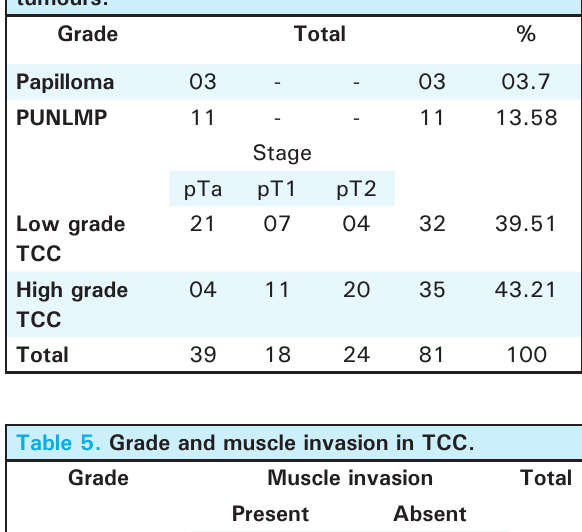
Table 4. Grading and staging of urothelial bladder tumours.